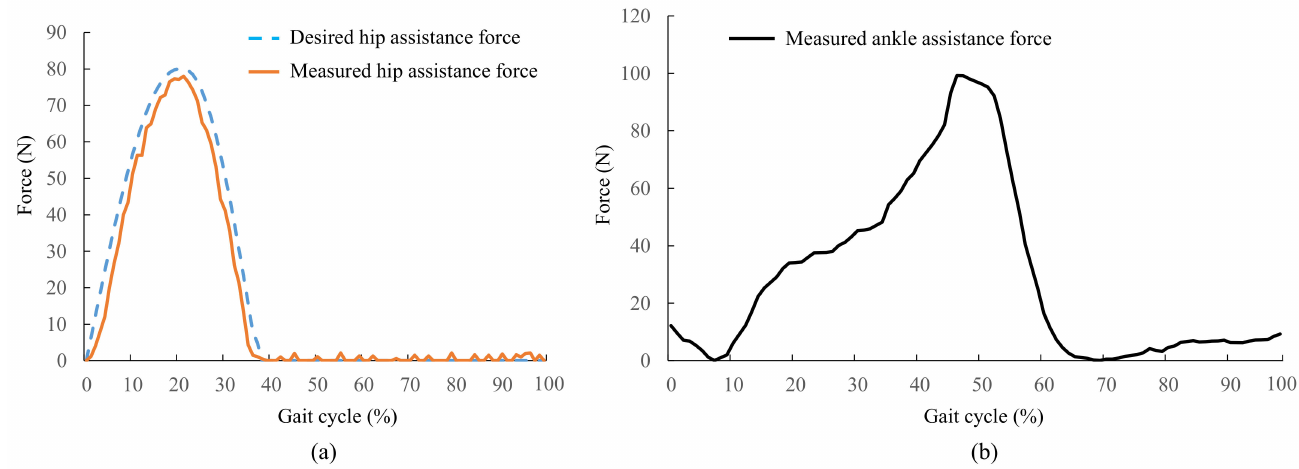
Figure 8. Active-passive assistance force. ( a ) Force tracking performance of active hip extension assistance; ( b ) the passive ankle assistance